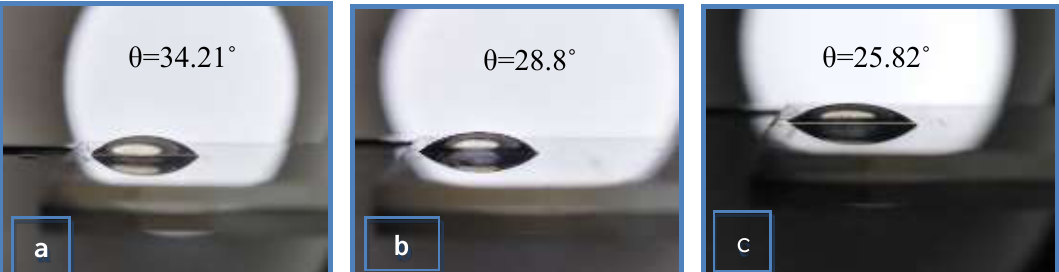
Fig.7b: Images of water droplet on the sample pure TiO b- after15 min. of Vis irradiation c- an hour Vis irradiation.